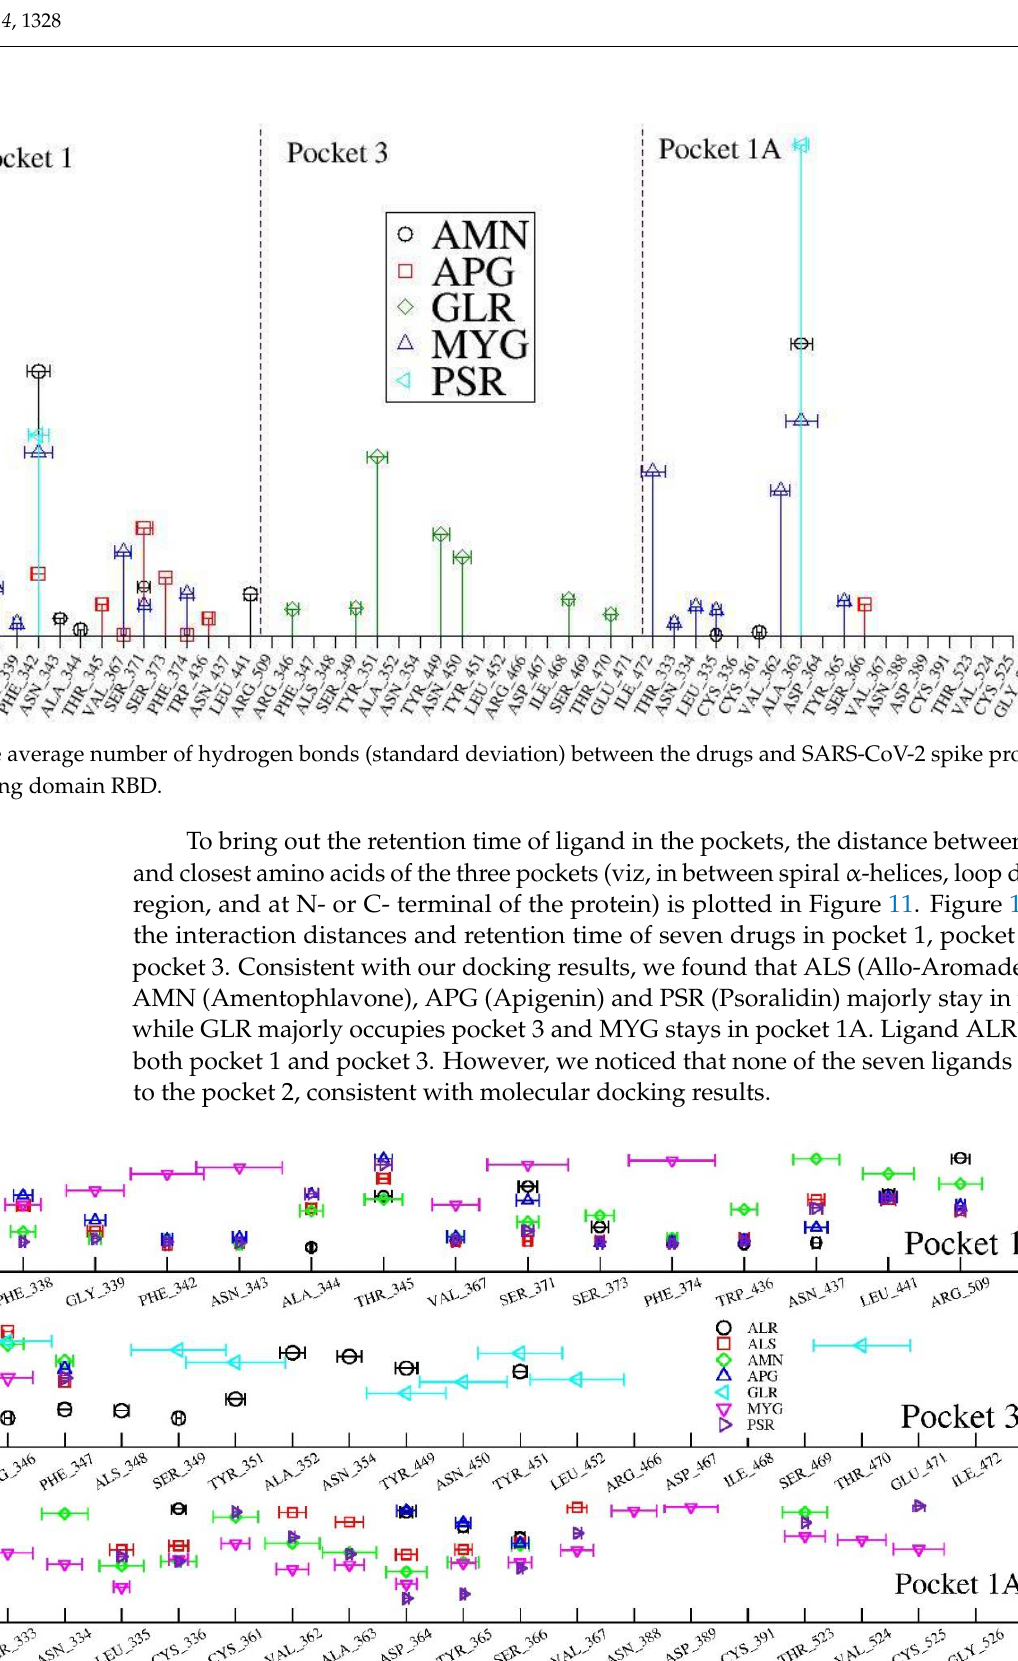
Figure 9. Representative snapshot of protein with ( a ) ALR, ( b ) ALS, ( c ) AMN, ( d ) APG, ( e ) GLR, ( f ) MYG and ( g ) PSR ligands. Here, solid spheres represent drug molecules, CPK model represents residues of protein, which are within 5 Å of the ligand and cartoon (grey) representation for protein.